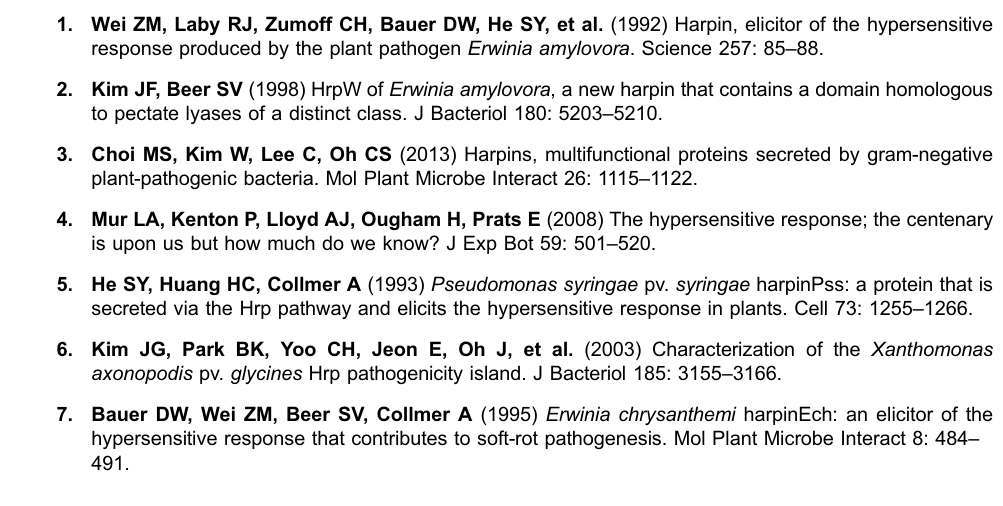
S3 Figure. Native PAGE. Lane 1: HrpZ doi:10.1371/journal.pone.0109871.s003 (TIF) S4 Figure. Primary structure of HrpZMM1, a HrpZ to residues 90-240 of the full length protein. Residues in bold correspond to hydrophobic heptadic amino acids, which could form leucine-zipper-like structures. doi:10.1371/journal.pone.0109871.s004 (TIF) S1 Table. Results of fluorescence quenching studies with C-214-HrpZ extent of quenching achieved by different quenchers and the corresponding quenching constants are given. The final quencher concentration in each case was 0.4 M. doi:10.1371/journal.pone.0109871.s005 (DOCX) S1 Method. Analysis of fluorescence data.